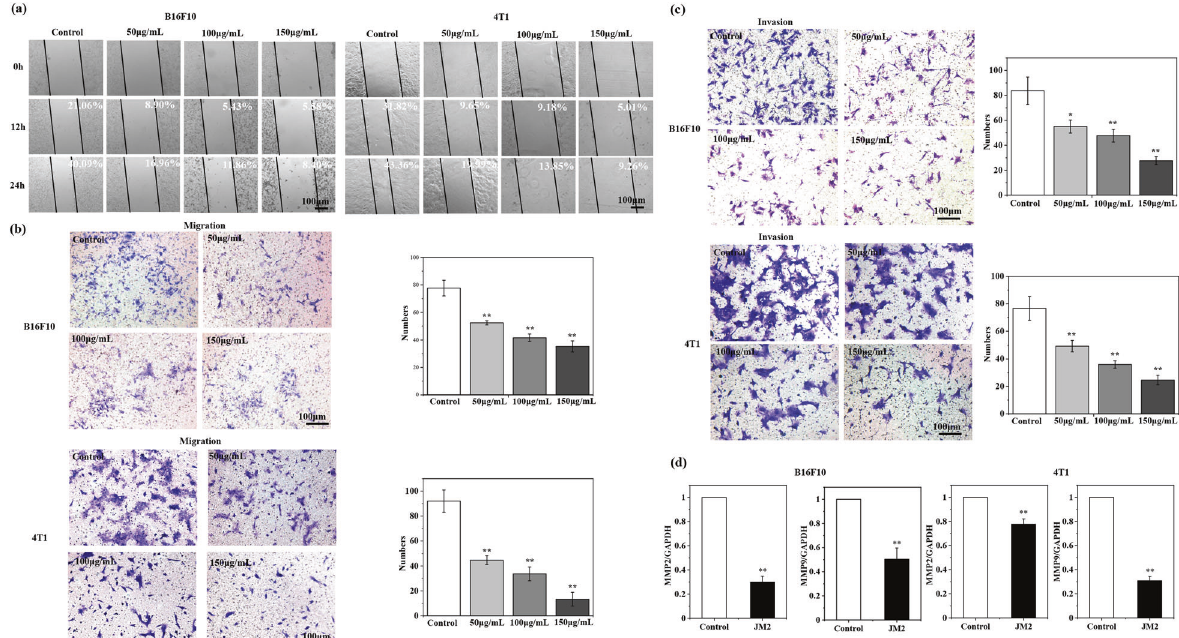
Fig. 3 JM2 inhibited migration of tumor cells. a In vitro wound healing of B16F10 and 4T1 cells cultured with JM2 solutions with different concentrations. b Migration of B16F10 and 4T1 cells cultured with JM2 solutions with different concentrations. c Invasion of B16F10 and 4T1 cells cultured with JM2 solutions with different concentrations. d Q-RT-PCR analysis of MMP2 and MMP9 mRNA in B16F10 and 4T1 cells. * p < 0.05 and ** p < 0.01 when the data was compared with the Control